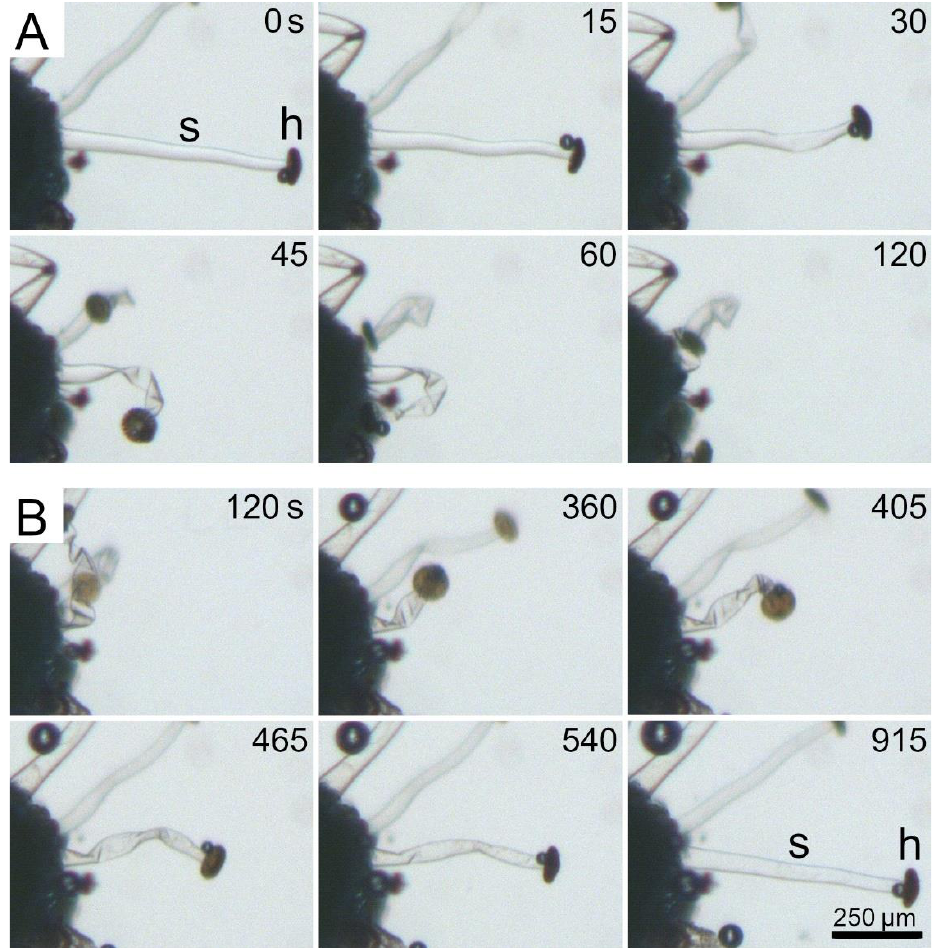
Figure 8. Dehydration and rehydration experiments. ( A ) Dehydration of a stalked gland in a hyper- tonic medium (saturated NaCl salt solution) and ( B ) its rehydration via immersion in a hypotonic medium (distilled water). The stalk cell (s) and head (h) are indicated. Both movements are basically identical in terms of their general patterns, but in reverse and with individual small differences and very different process times. Times [min] are indicated. The images are frames from Movie S10.